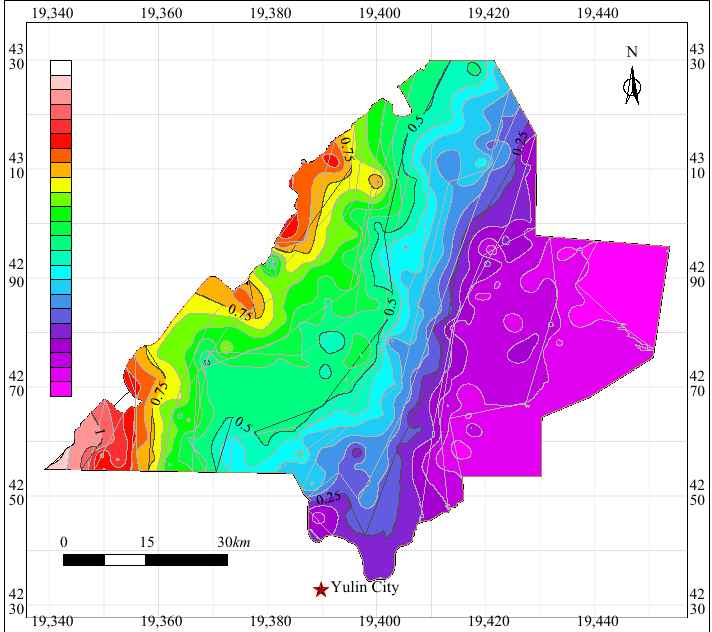
Figure 13. Contour map of the compression rate (×10 2 ) of CMFB in the Yu-Shen coal area.